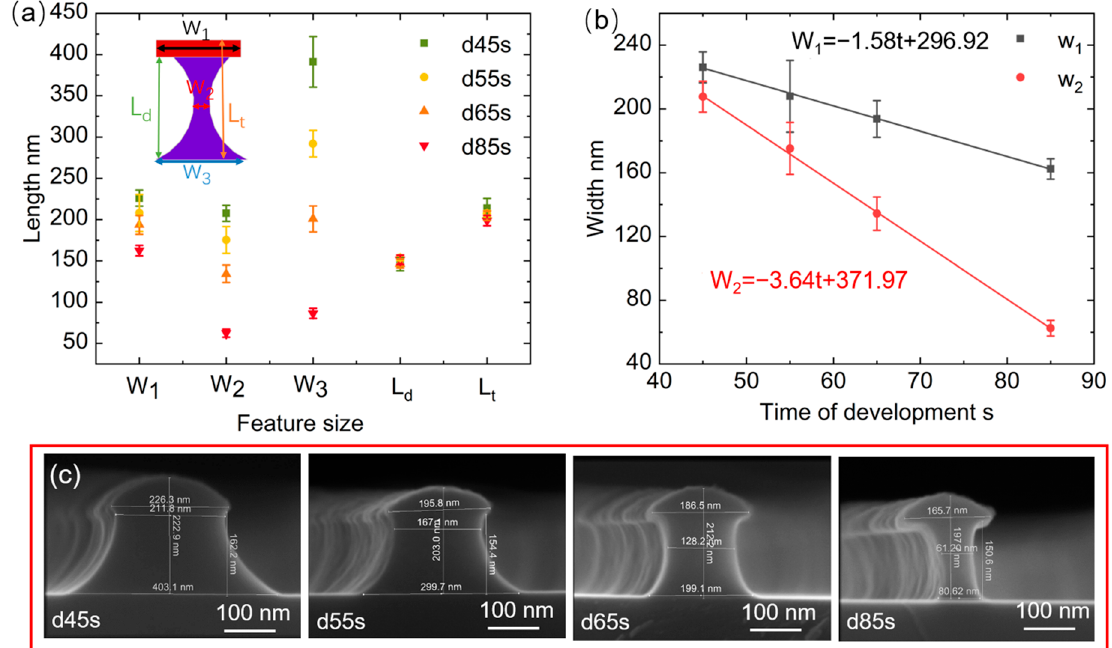
Figure 3. The feature size changing with the developing time. ( a ) The average value and standard deviation of feature size calculated from photoresist gratings under different developing times shown in Figure 2; ( b ) the width of top photoresist presented by w 1 and the width of bottom photoresist presented by w 2 vary with developing time. The linear fitting of the width versus the developing time indicates that the developing speed of the top photoresist is 1.58 nm/s and the developing speed of bottom photoresist is 3.64 nm/s. ( c ) The SEM image of photoresist on silicon developing for different time labelled with size.